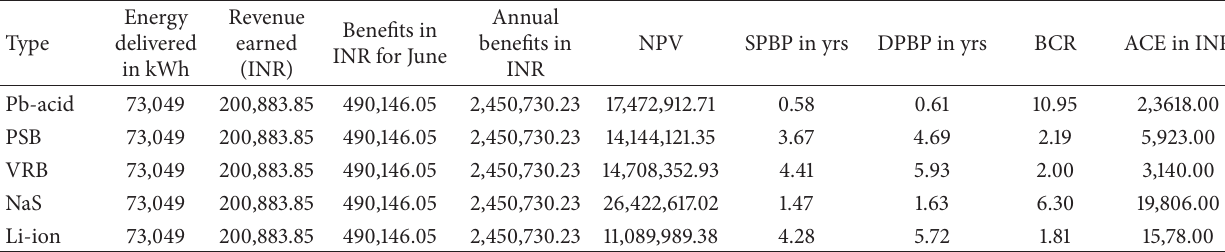
Table 9: Economic analysis after